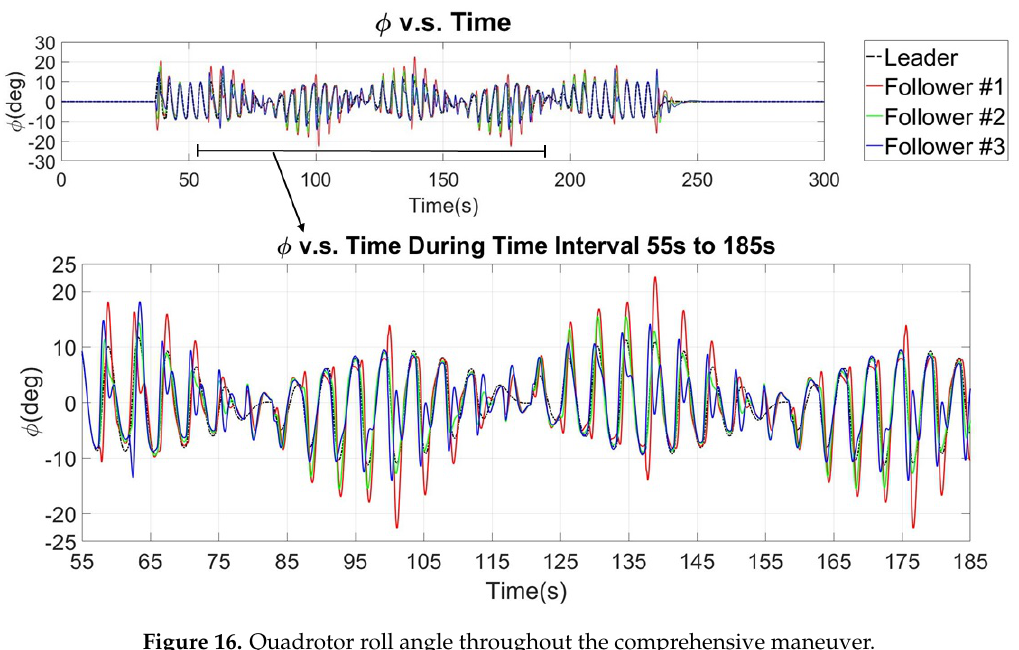
Figure 16. Quadrotor roll angle throughout the comprehensive maneuver.